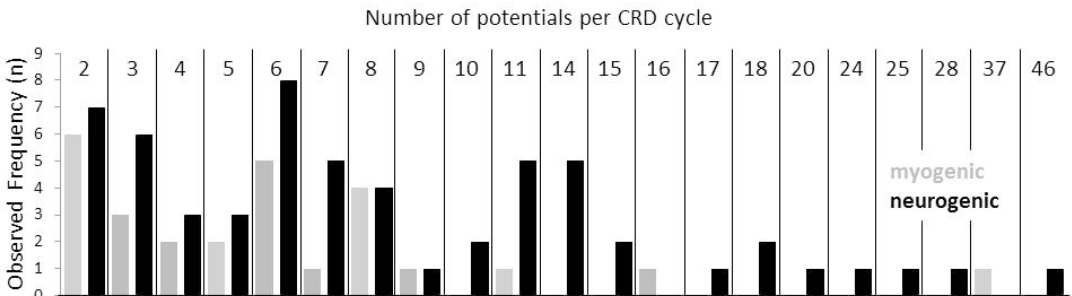
Figure 5. Relative complex repetitive discharge (CRD) frequencies are summarized in neurogenic (black columns) and myogenic disorders (grey columns) according to the numbers of single components forming a CRD cycle. Note that the observed relative frequencies are not evenly distributed but form peaks at single component numbers around 2/3, 6/7/8 and 11/14. Hypothetically, this type of distribution may correspond to certain sites of myo-axonal contacts within the axonal tree.